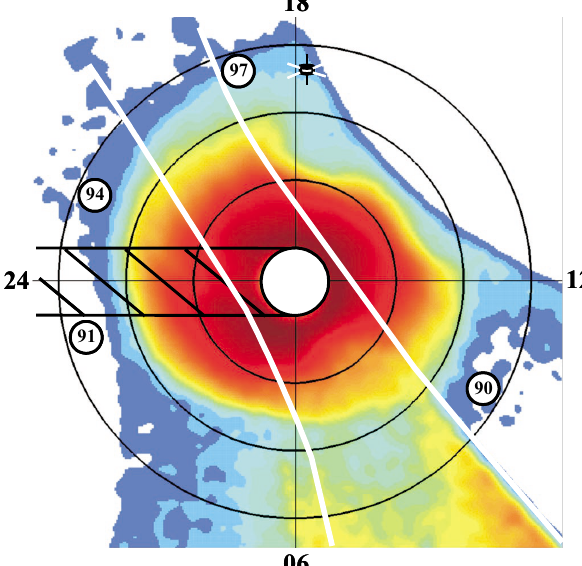
Fig. 13. Projection of a full-frame EUV image onto the equatorial plane at 12:33 UT on 2 June 2002 (similar as Fig. 7, with also the position of LANL